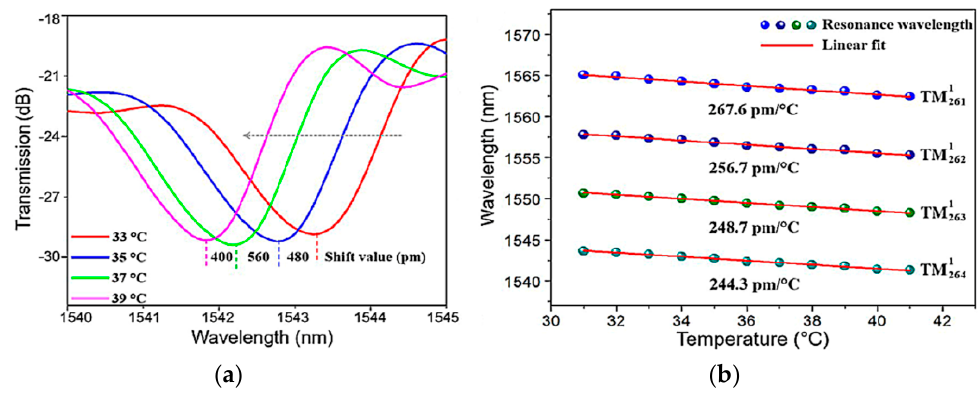
Figure 15. ( a ) Shift of WGM resonance at different temperatures; ( b ) relationship between the wavelength and temperature for different modes. [Reprinted/Adapted] with permission from ref [46], [OSA].